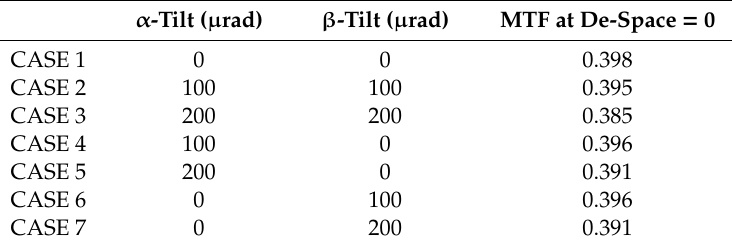
Table 2. Case study to identify the variation of MTF.